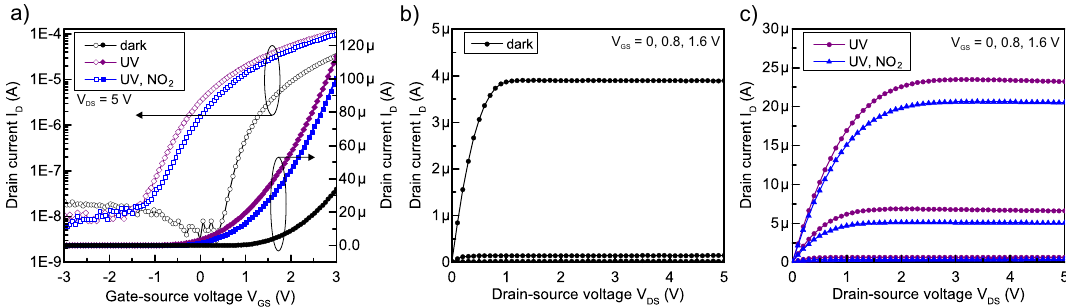
Figure 4. Electrical characteristics of the a-IGZO TFT (W/L = 280µm/80µm) gas sensor in dark condition, under UV-light illumination and while exposed to UV-light and 5 ppm NO 2 . For all measurements, the background oxygen was set to 20%. The measurement under UV-light was performed after 2min illumination. ( a ) transfer characteristics and ( b , c ) output